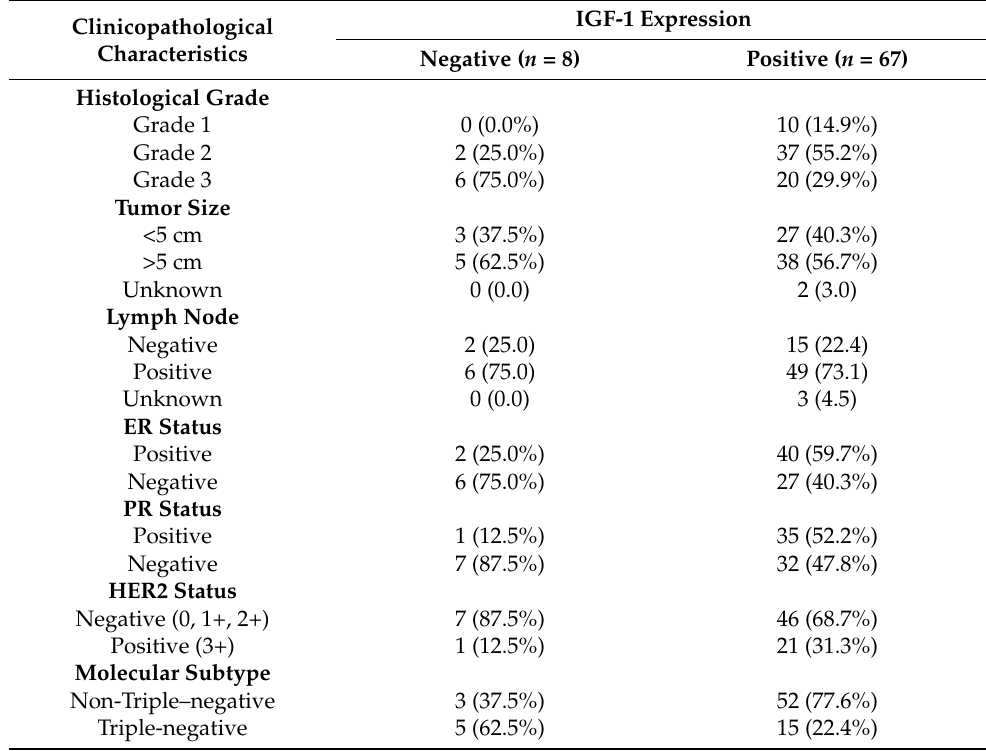
Table 8. Patients’ clinicopathological characteristics based on the IGF-1 status ( n =